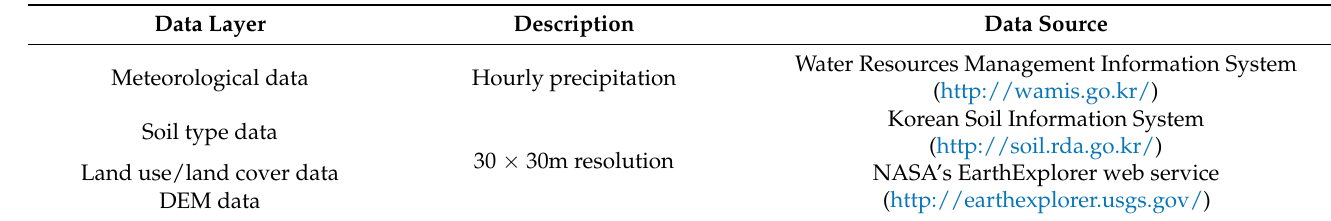
Table 3. Information about the data used in this